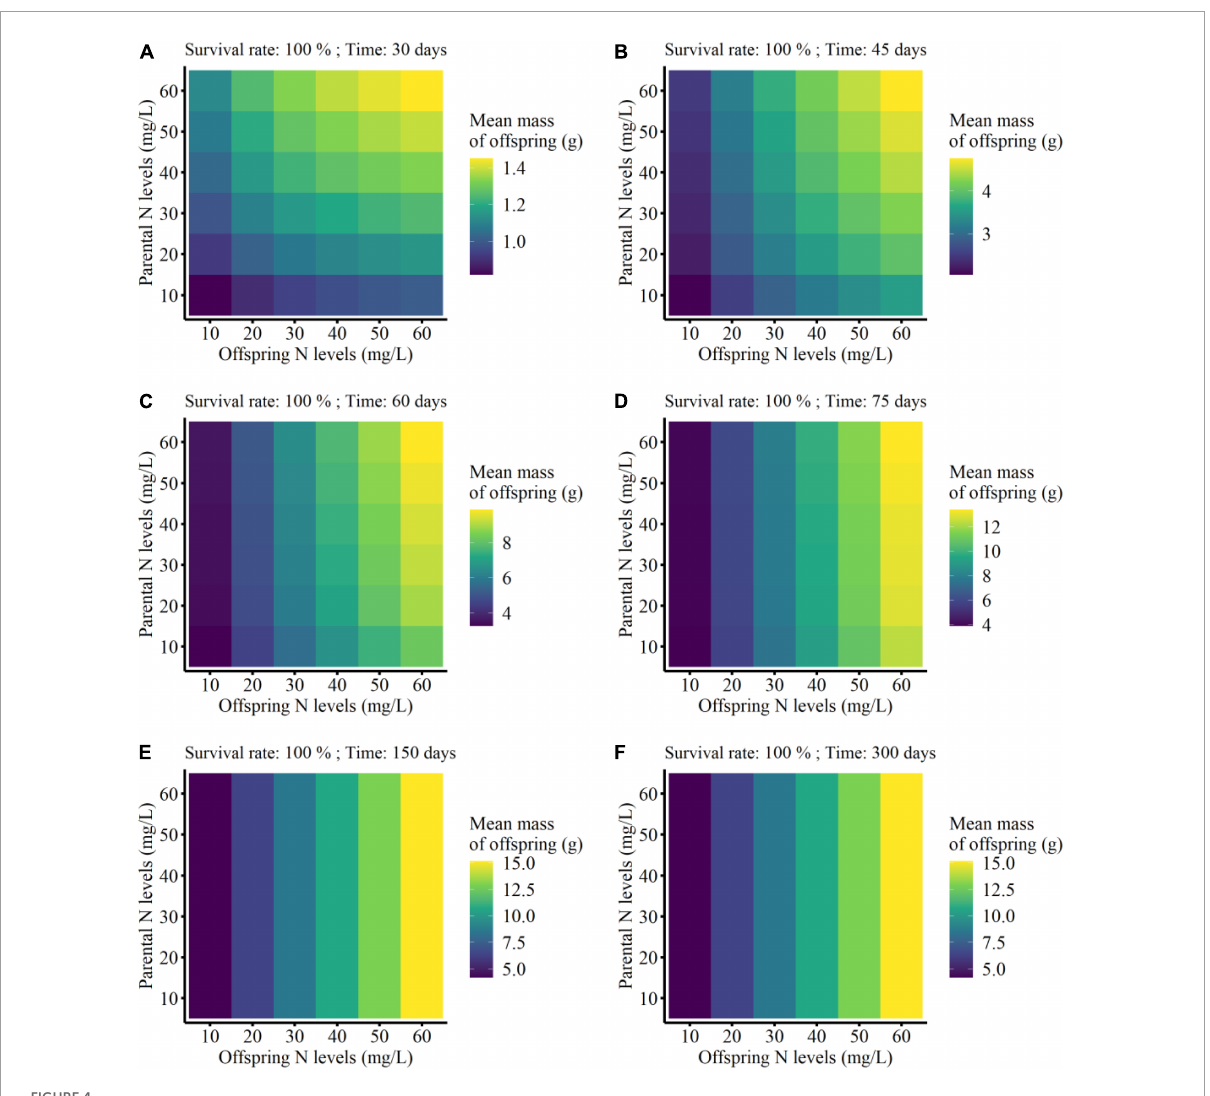
FIGURE4 Mean finial mass of the offspring grown from the surviving clonal propagules of each parental plant at the different developmental time (from 30 to 300 days; A–F ) in the simulation experiment. The mean performance of clonal offspring with 100% survival rate were shown